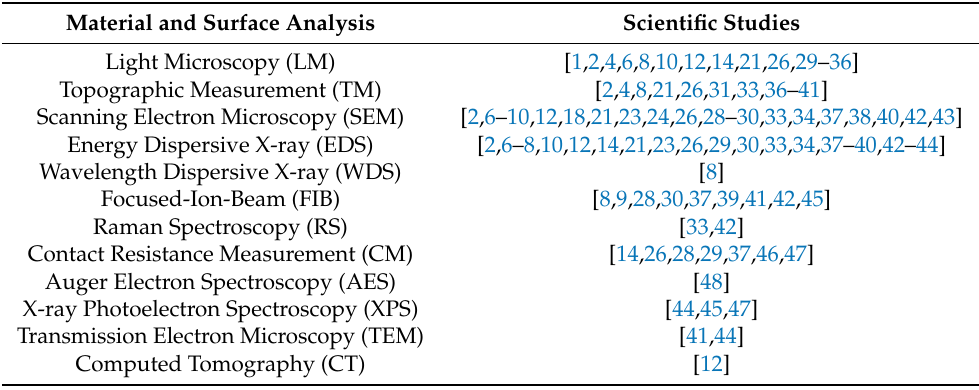
Table 1. Overview of methods of material and surface analysis used in scientific studies for the analysis of damage mechanisms for electrical